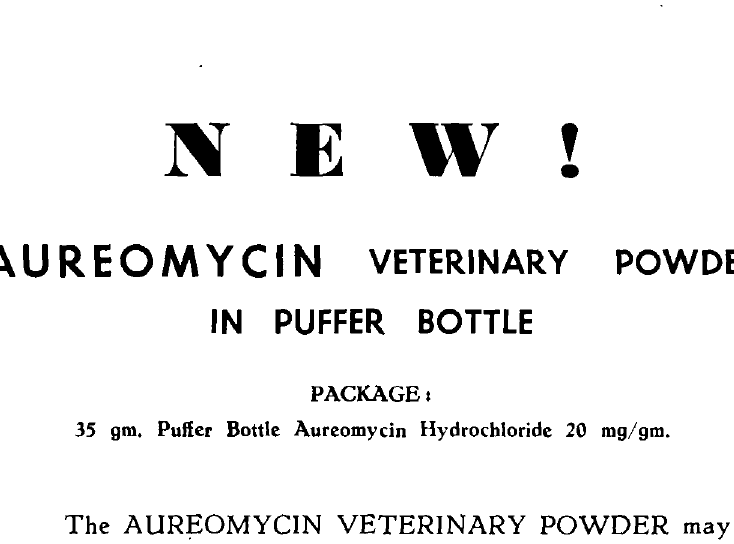
SOLUBLE OBLET! 500